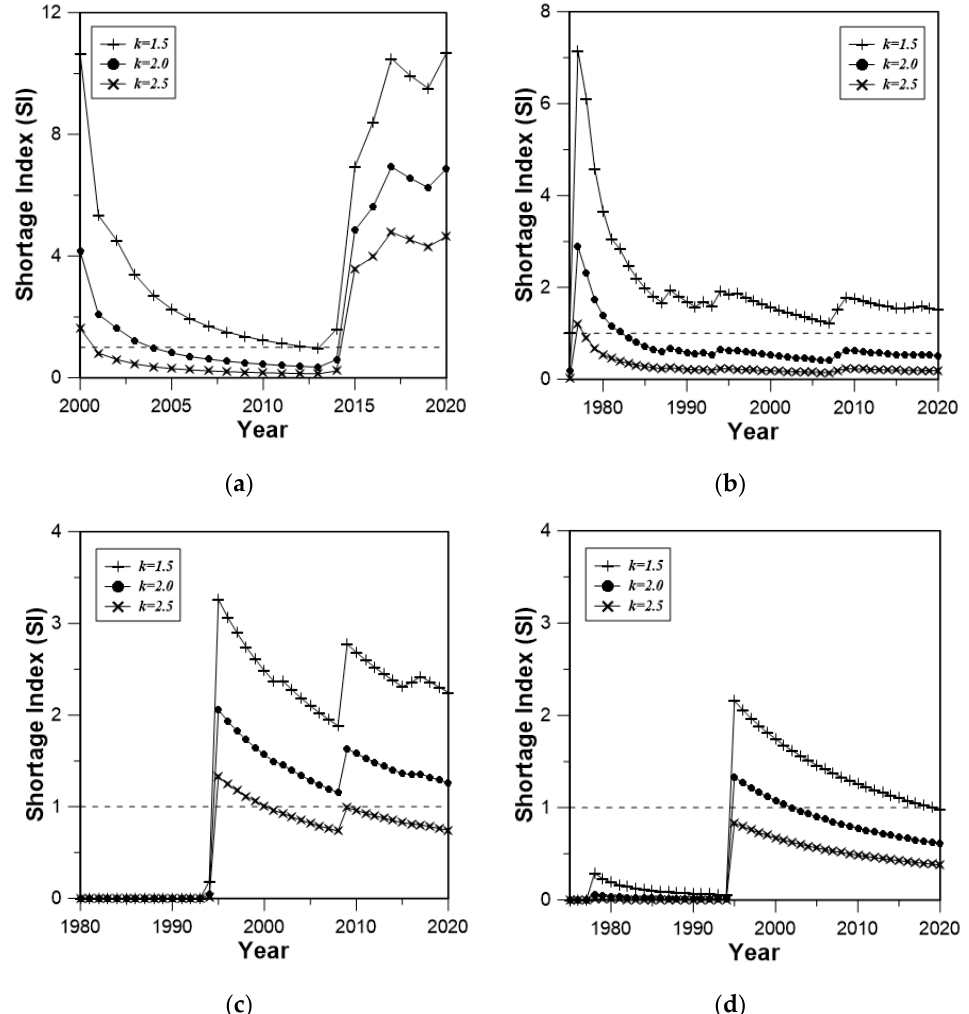
Figure 6. Estimation results of SI derived with three different values of k (1.5, 2.0, and 2.5): ( a ) Heongseong Dam (located in the Han River Basin), ( b ) Namgang Dam (located in the Nakdong River Basin), ( c ) Daecheong Dam (located in the Geum River Basin), and ( d ) Seomjingang Dam (located in the Seomjin River Basin).